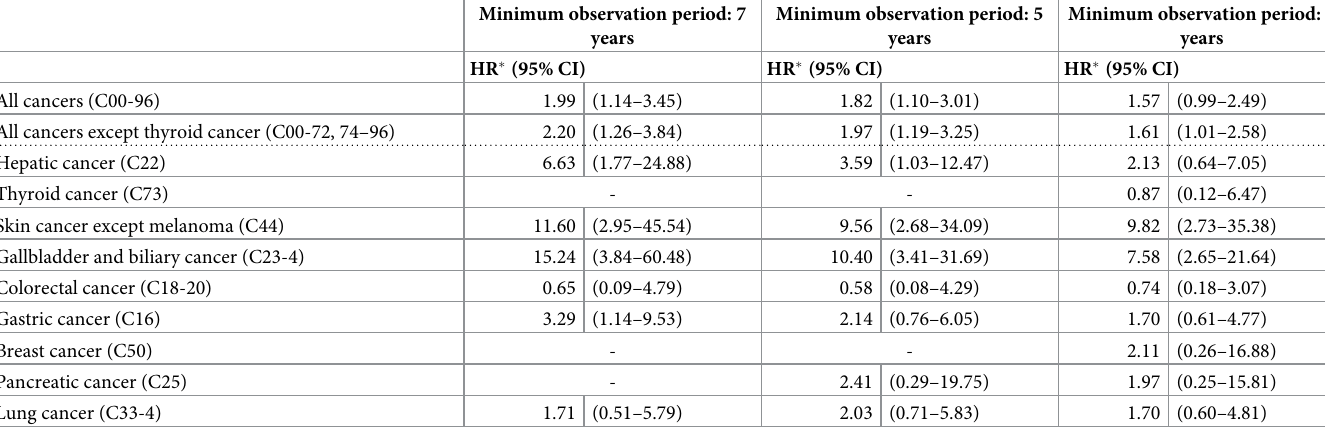
Table 3. The hazard ratio of the living in the Jang-jeom village compared to the neighborhood